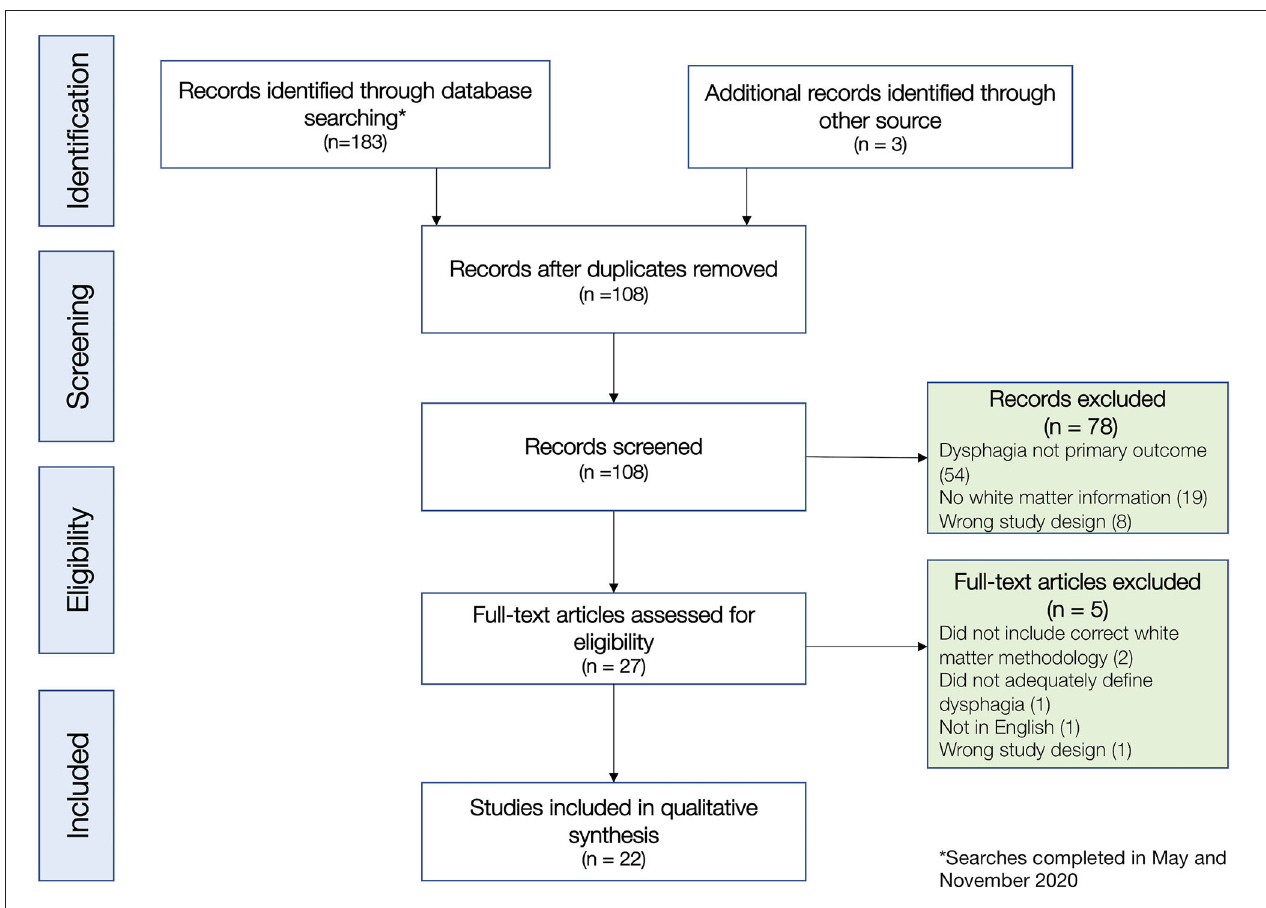
FIGURE 1 | Study selection flow diagram, according to PRISMA